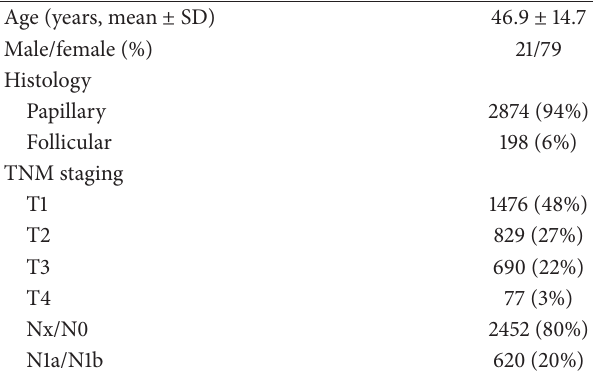
Table 1: Characteristics of all participants ( 𝑛 = 3072